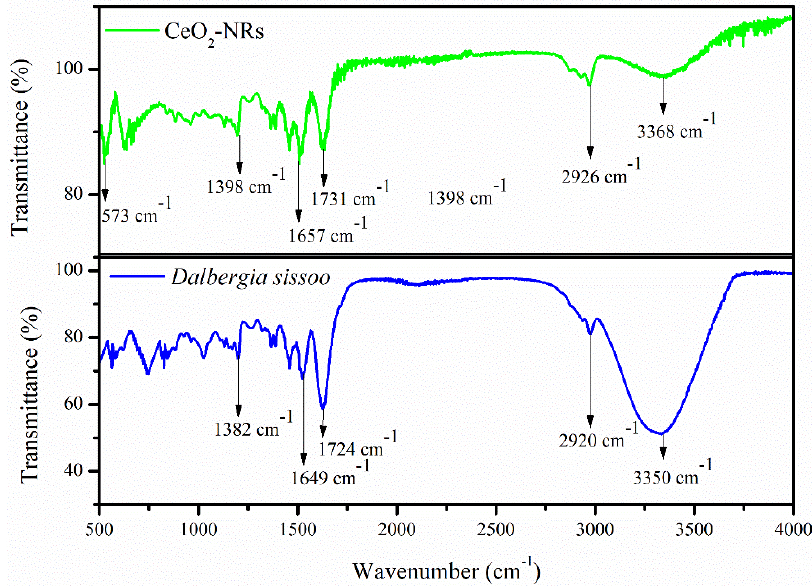
Figure 5. FTIR spectrum of D. sissoo and CeO 2 -NRs.